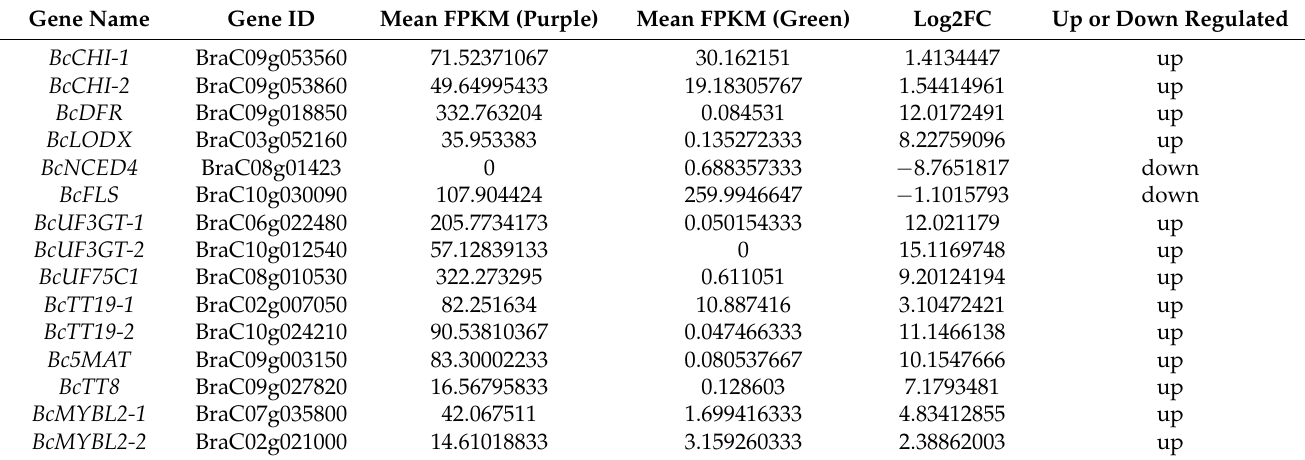
Table 2. Anthocyanin-Containing Compound Biosynthetic Process (qvalue = 2.71 × 10 − 6 ).